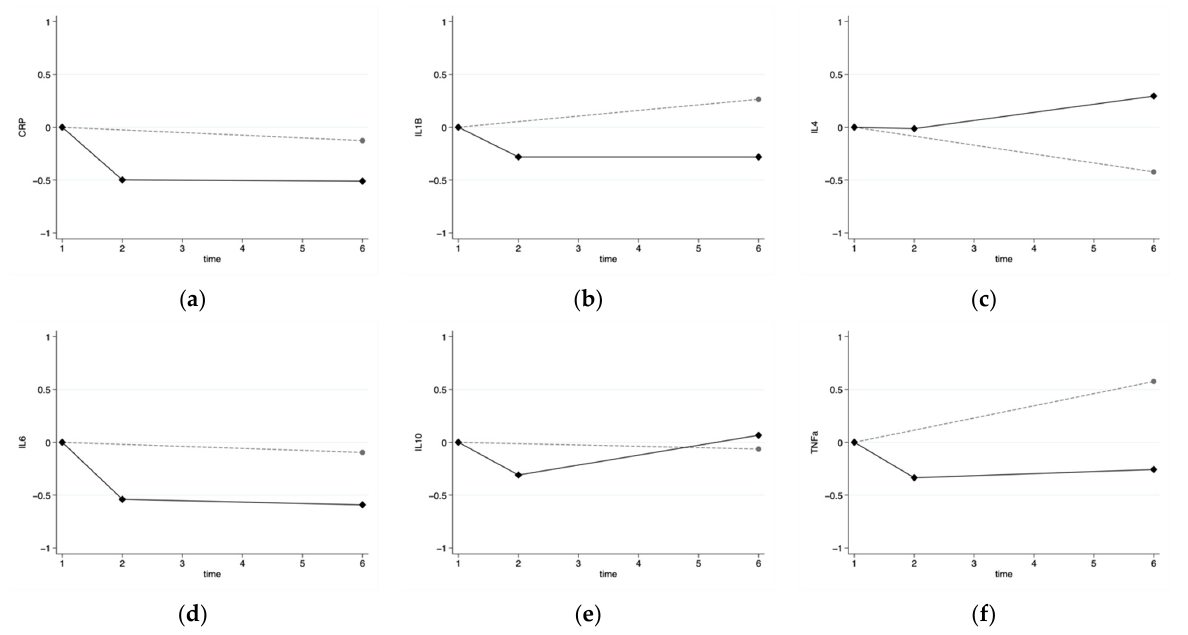
Figure 2. Progression of the inflammatory markers’ levels throughout the weeks in both the control (dotted gray line) and infection (solid black line) groups: ( a ) C-reactive protein; ( b ) IL1; ( c ) IL4; ( d ) IL6; ( e ) IL10; and ( f ) TNF α .